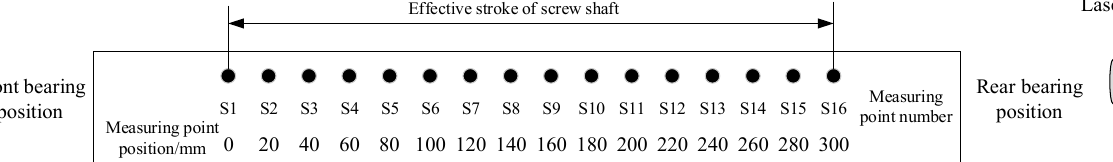
Figure 3. Distribution of measuring points. Table 3. Experimental parameters.